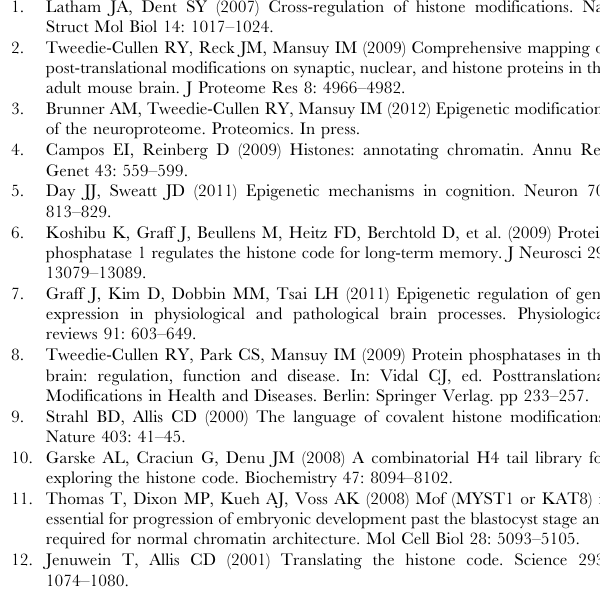
Figure S1 Frequency plot of the amino acids surround- ing lysines (A) or arginines (B) across all histones in the mouse. Frequency plot of the amino acids surrounding sites of modification detected in this study; acetylation of lysine (C), methylation of lysine (D) and arginine (E), and phosphorylation of Ser/Thr/Tyr (F). The frequency of amino acids surrounding the modified residue was different for each type of modification, and different to the typical amino acid frequency seen surrounding lysines and arginines across all histones. These different frequen- cies likely reflect the different enzymes that act on the sites. Figure S2 Using the web-based tool Motif-X we ana- lysed the motifs surrounding modification sites on histones, revealing over-represented acetylation, meth- ylation and phosphorylation motifs. For the motif extrac- tion, pS, pT or pY-centered 11 amino acid sequences were used. To minimise extraction of randomly occurring patterns, we utilised the Motif-X algorithm, which takes the background dataset into account for pattern extraction. Because the amino acid composition in histones is different to the average across all proteins, we used a reference database only containing histones. Figure S3 Comparison of predicted and experimentally observed acetylation sites. Putative lysine acetylation sites (1st column) were predicted by the acetylation prediction tool PredMod to be acetylated (ac) or not (unmodified) (2nd column). The predicted results were compared to what we observed in our CID/ETD MS experiments (3rd column). The overlap of predicted and experimentally verified sites was calculated in percentage. Figure S4 207 peptides corresponding to the C-terminal proximal end of Histone H2A (H2A 93–121 ) were identified via ETD MS. In most cases only K99 was dimethylated, preventing the analysis of combinatorial patterns.